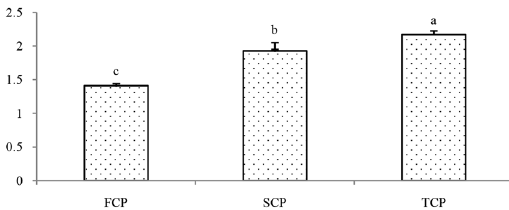
Figure 4. Sum of AWCD values of amino acids, carboxylic acids and phenolic compounds at 96 h.